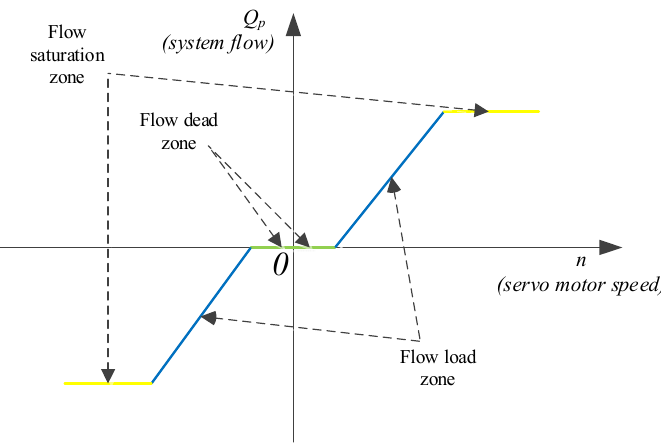
Figure 2. Schematic diagram of the characteristics of the control system flow output zone.